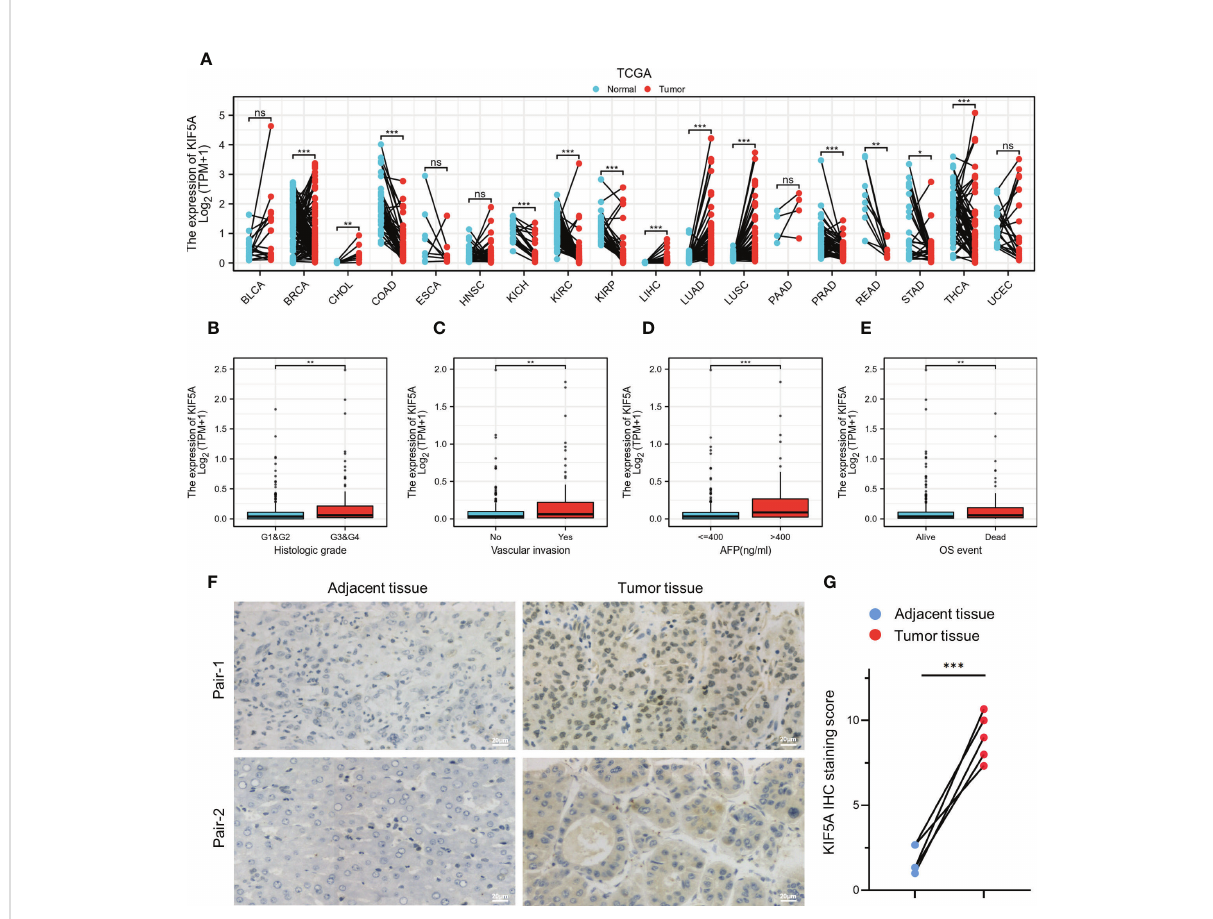
FIGURE 1 Elevated KIF5A expression in LIHC. (A) Pan-cancer analyses of KIF5A expression level based on TCGA database. (B) Correlation between KIF5A expression and histologic grade in LIHC. (C) Correlation between KIF5A expression and vascular invasion in LIHC. (D) Correlation between KIF5A expression and AFP level in LIHC. (E) Correlation between KIF5A expression and OS event in LIHC. (F) Representative IHC staining in LIHC and paired adjacent tissue. Scare bars, 20 m m. (G) Analysis of IHC staining score of KIF5A in LIHC and paired adjacent tissue. Statistical signi fi cance was determined using the paired Student ’ s t-test. *** p < 0.001, ** p < 0.01, * p < 0.05, ns not signi fi